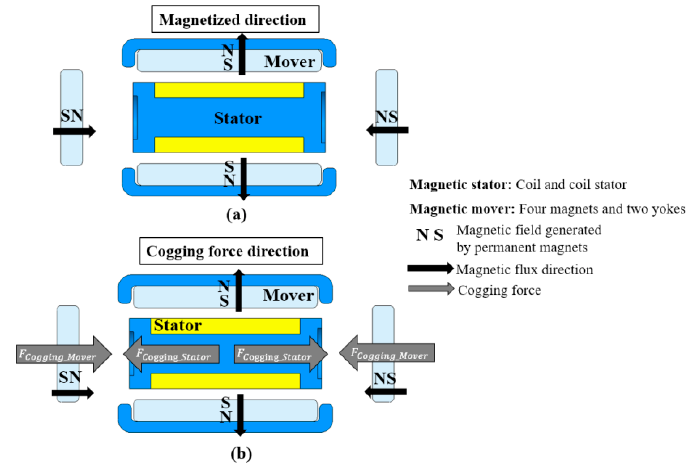
Figure 5. Cogging force: ( a ) magnetized direction and ( b ) cogging force direction.